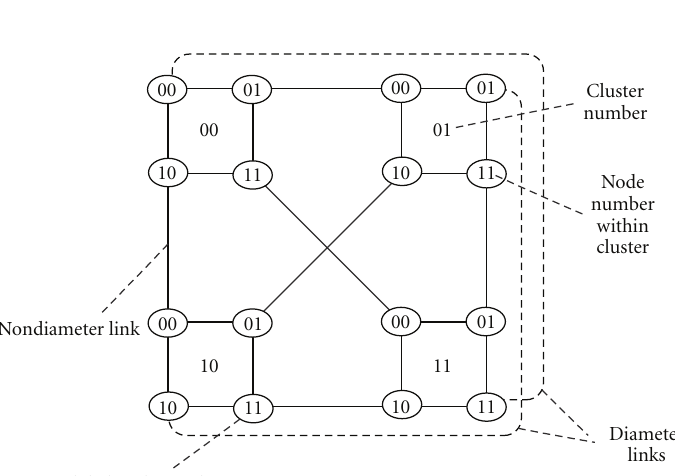
Figure 7: A 5-HHC [8].